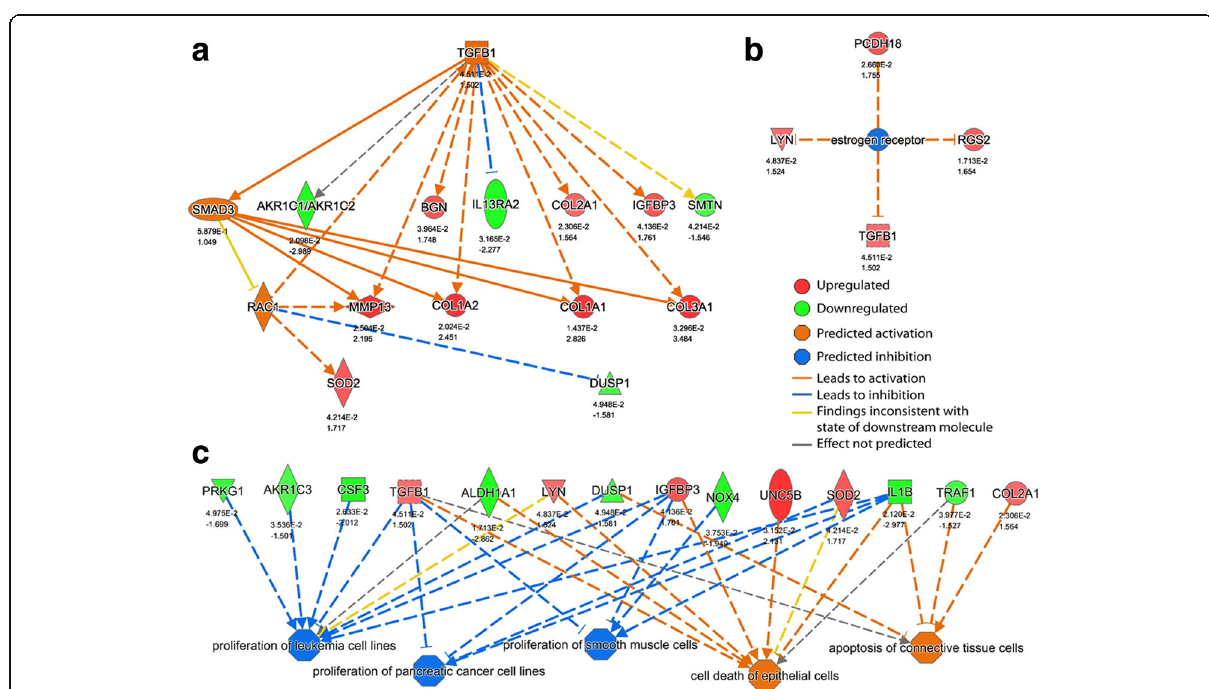
Fig. 4 Upstream regulators and downstream biological effects predicted by Ingenuity Pathway Analysis on the proteome level. The “ master regulators ” of the analyzed dataset were predicted (blue and orange octagons), based on regulated proteins (green and red symbols indicate a fold change > |1.5| and a q-value <0.05) and literature data from the Ingenuity Knowledge Data Base. ( a ) TGF- β 1, SMAD3, and RAC1 were the only upstream regulators predicted to be active, and ( b ) the estrogen receptor (group) was the only regulator predicted to be inhibited, when the full length syndecan-1 was expressed. ( c ) Regulated proteins were predicted to lead to a set of downstream biological effects, all pertaining to cell viability. All predicted regulators had a Z-score (activation score)>|1.9|, and a Fisher ’ s exact p -value <0.05. Dashed lines are indirect effects, and the shape of the protein indicates the protein class (defined by IPA). Magnitude of regulations: TGF- β 1 (Z-score = 2.62, P -value = 1.42e-06), SMAD3 (Z-score = 1.98, P -value = 1.38e-06), RAC1 (Z-score = 1.96, P -value = 2.15e-04), and the estrogen receptor (group) (Z-score = − 2.0, P -value = 2.54e-02); proliferation of leukemia cell lines (Z-score = − 2.08, P -value = 4.59e-06), proliferation of pancreatic cancer cell lines (Z-score = − 1.96, P -value = 3.38e-03), proliferation of smooth muscle cells (Z-score = − 1.95, P -value = 5.27e-03); death of epithelial cells (Z-score = 1.99, P -value = 5.96e-04), and apoptosis of connective tissue cells (Z-score = 1.91, P -value =